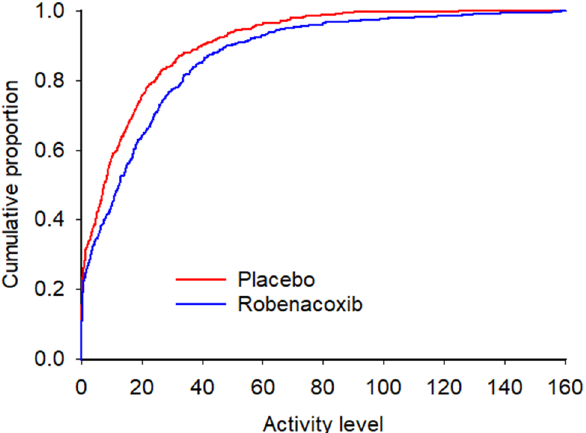
Figure 2. Example cumulative distribution function for a single cat (LAS-31), demonstrating a rightward shift of activity during treatment with robenacoxib, as compared against treatment with placebo. This indicates that the activity counts were higher while receiving robenacoxib. P values from the Kolmogorov–Smirnov test were < 0.0001 for the hypothesis that activity with robenacoxib > placebo, and 1.0 for placebo > robenacoxib. Analysis and graphical output performed using SAS software capabilities (Version 9, SAS Institute Inc., Cary, NC).